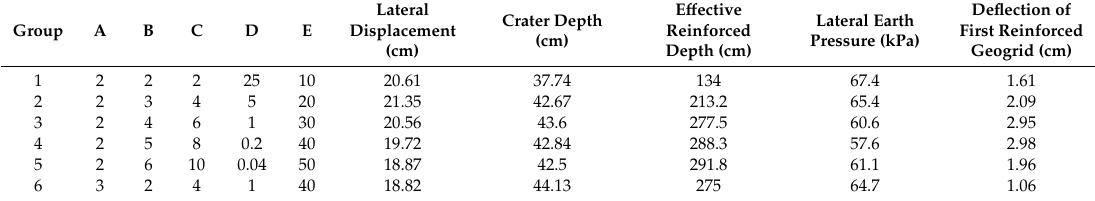
Table 7. The plan and results of orthogonal